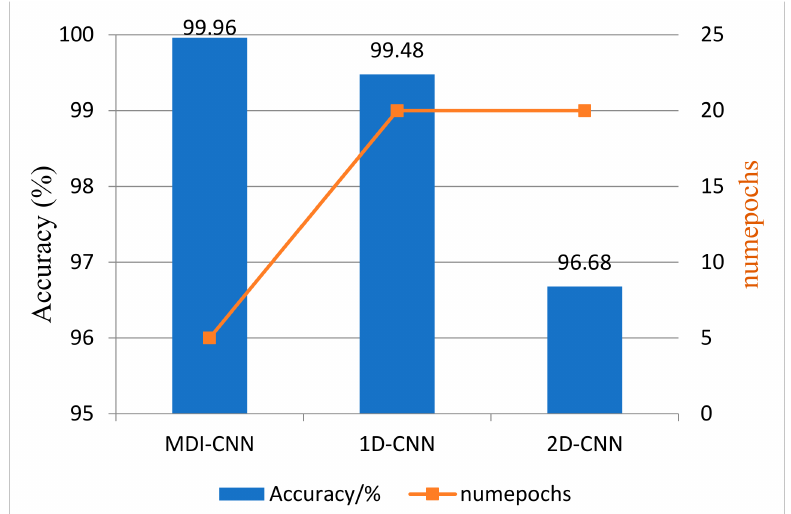
Figure 6. The accuracy of di ff erent models.